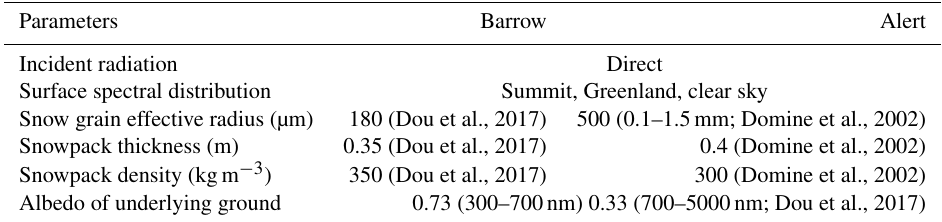
Table 1. The input parameters in the SNICAR model. Parameters